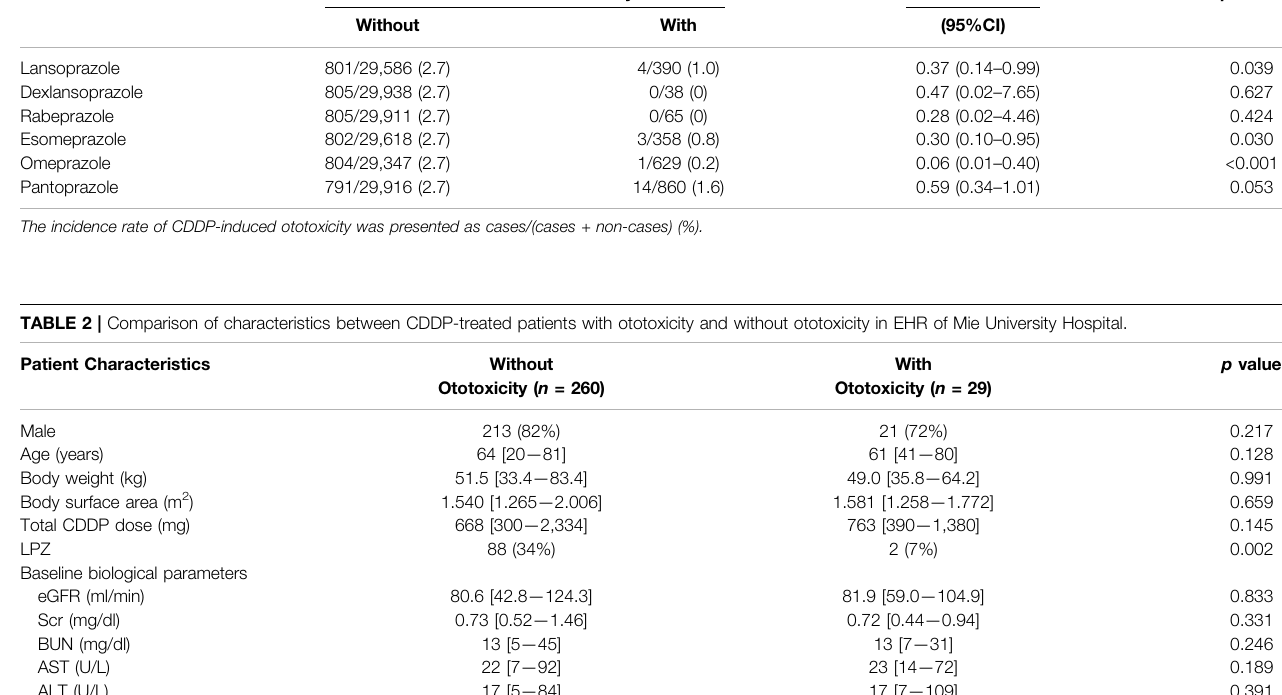
TABLE 1 | Effect of PPIs on the incidence of CDDP-induced ototoxicity in FAERS. PPIs